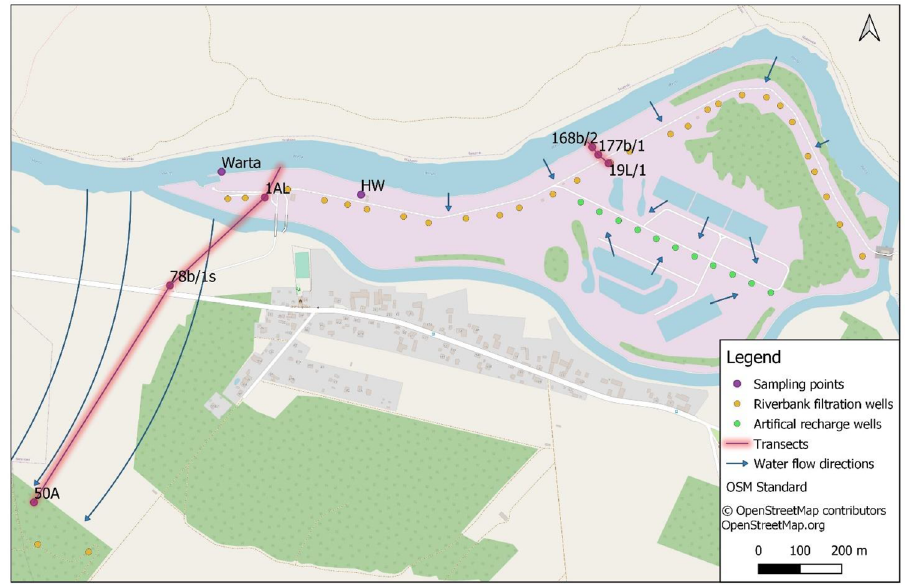
Figure 1. Map of the study